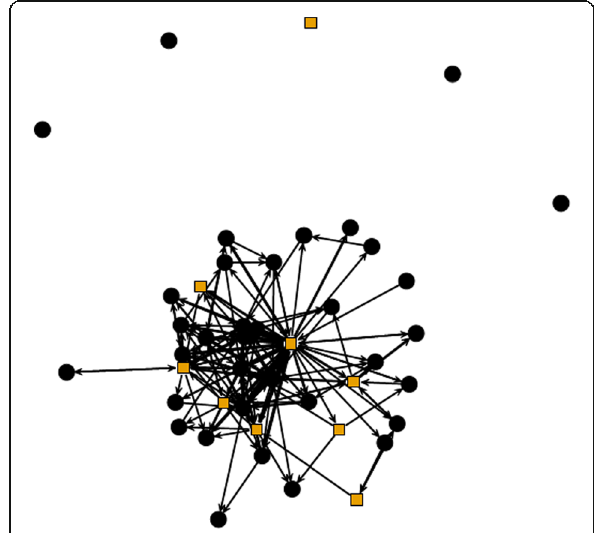
Fig. 1 Network diagram of connections between participants (dark circles) and facilitators (light squares) on group listserv